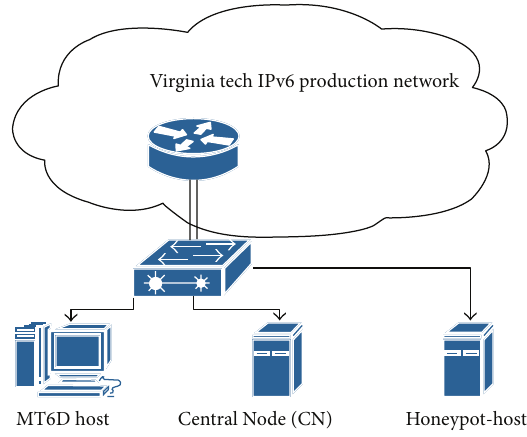
Figure 1: Block diagram of test